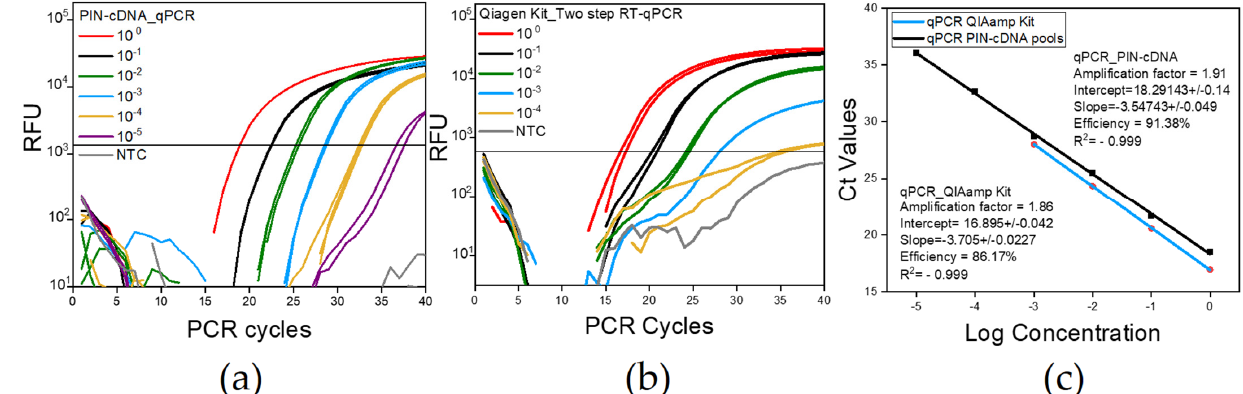
Figure 6. The LoD and PCR efficiency differences between the two methods; figures show one